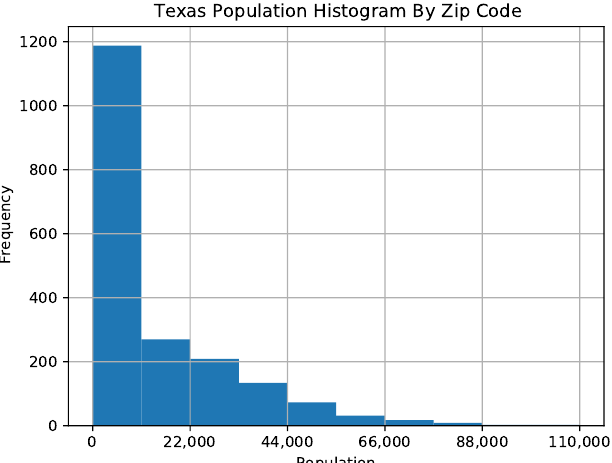
Figure 1. Texas population histogram by zip code.